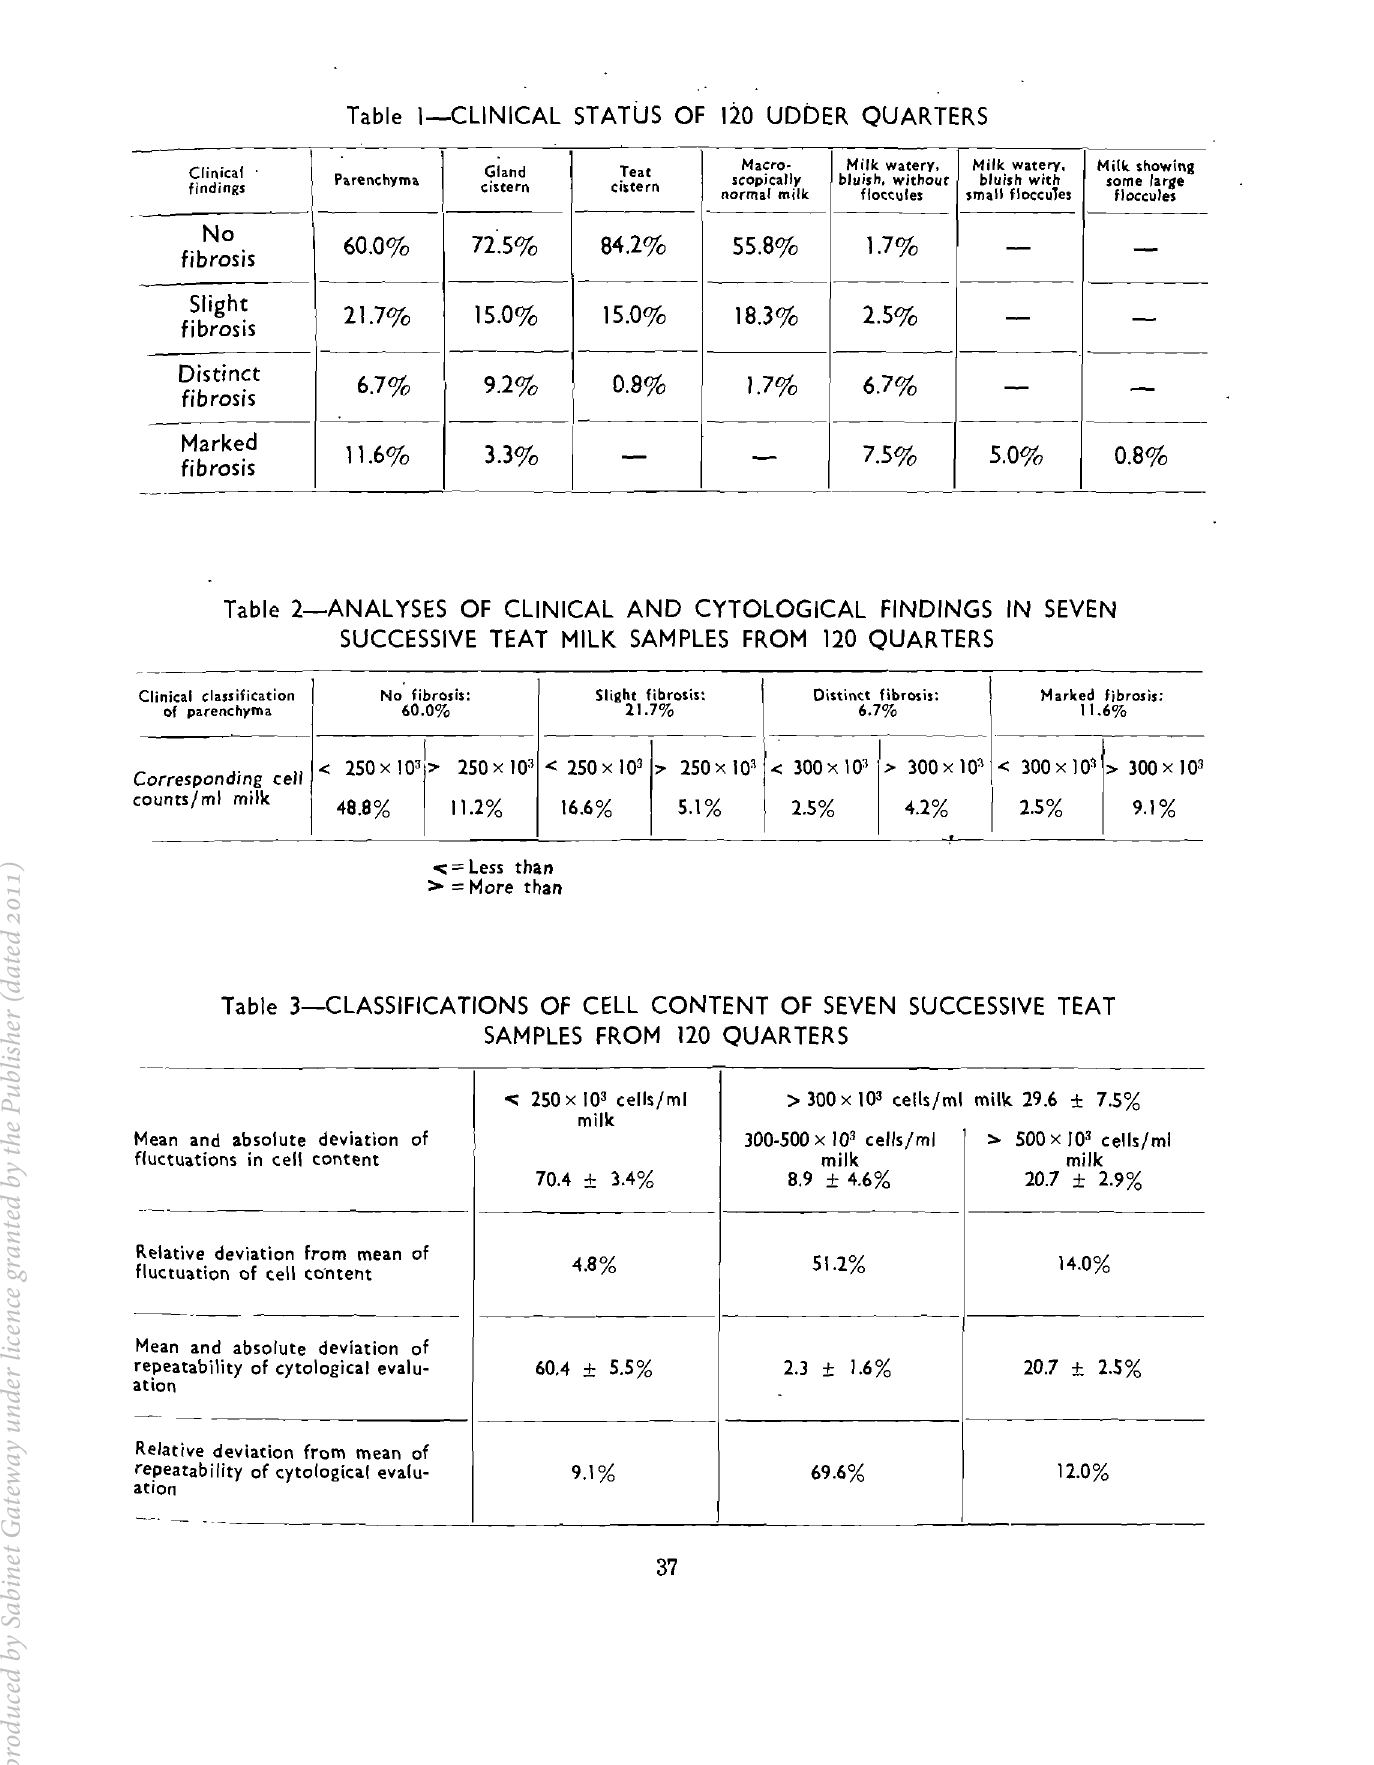
Table 2-ANAL YSES OF CLINICAL AND CYTOLOGICAL FINDINGS IN SEVEN